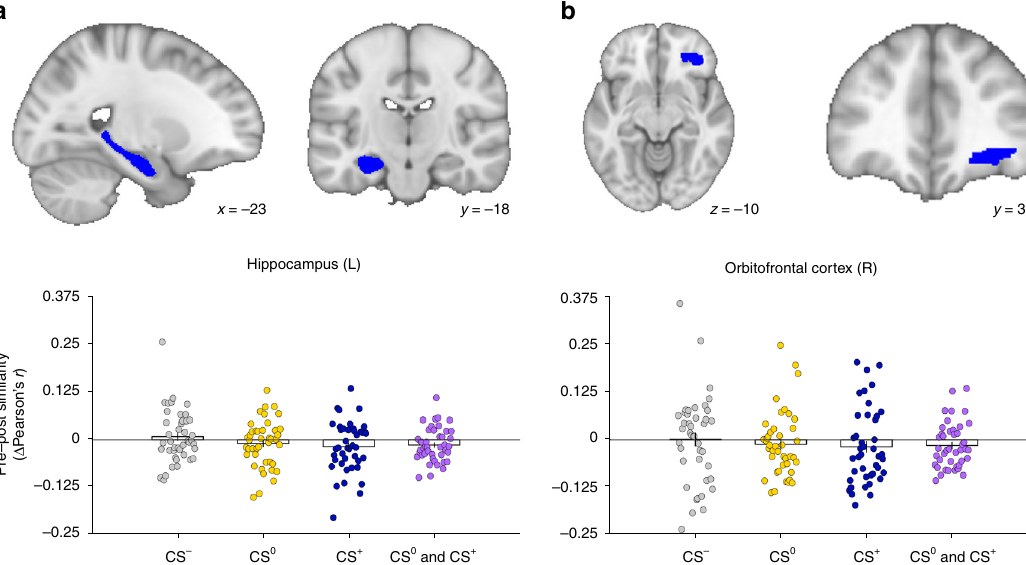
Fig. 3 Multivariate neural pattern similarity analysis results. a Multivariate neural pattern similarity analyses in the left hippocampus and b right lateral OFC, showing that neural similarity (POST r – PRE r , Δ Pearson ’ s r ) between same value stimulus – outcome pairs decreased from PRE to POST (cid:2) US (cid:2) / CS 0 (cid:2) US (cid:2) and CS 0 (cid:2) US þ / CS 0 (cid:2) US þ (Hippocampus: t = 1.01, P = 0.144, U 3 = 0.50, 1 – β = 0.28, one-sample ( N = 42). CS 0 (yellow): CS 0 41 1 A B A B t -test, one-tailed; lateral OFC: t = 1.55, P = 0.061, U 3 = 0.62, 1 – β = 0.13, one-sample t -test, one-tailed); CS + (blue): CS þ (cid:2) US (cid:2) / CS þ (cid:2) US (cid:2) and 41 1 A B CS þ A (cid:2) US 0 / CS þ B (cid:2) US 0 (Hippocampus: t 41 = 1.81, P = 0.039, U 3 1 = 0.57, 1 – β = 0.53, one-sample t -test, one-tailed; lateral OFC: t 41 = 1.23, P = 0.113, U 3 1 = 0.64, 1 – β = 0.23, one-sample t -test, one-tailed); CS 0 and CS + (purple): average of CS 0 and CS + (Hippocampus: t 41 = 2.09, P = 0.021, U 3 1 = 0.64, 1 – β = = CS (cid:2) neural pattern similarity for the control stimulus pairs CS (cid:2) (CS − , gray) was numerically positive (Hippocampus: t 41 = 0.76, P = 0.451, U 3 1 = 0.57, A B 1 – β = 0.12, one-sample t -test, two-tailed; lateral OFC: t 41 = 0.04, P = 0.969, U 3 1 = 0.43, 1 – β = 0.05, one-sample t -test, two-tailed), indicating higher similarity from PRE to POST. Bar plots represent sample means. Error bars indicate standard errors of the mean. Source data are provided as a Source Data fi